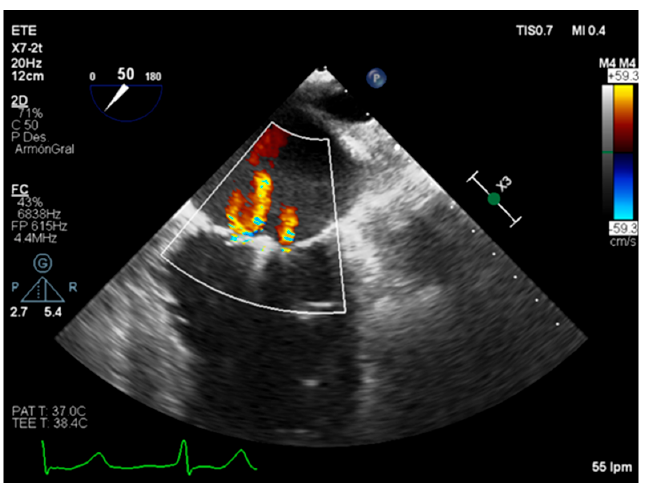
Figure 4. Transesophageal echocardiography. Disproportional mitral regurgitation in a non-ischemic dilated cardiomyopathy.